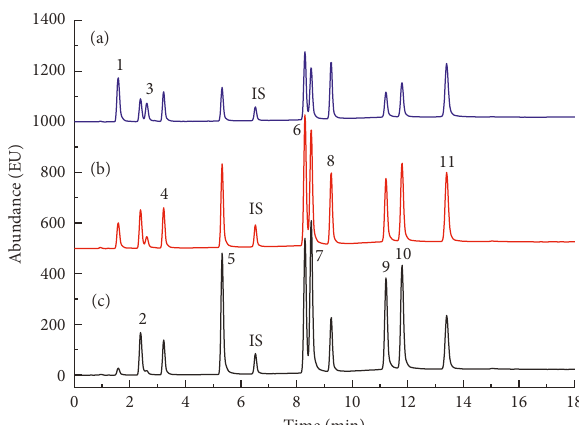
Figure 2: Chromatograms of the standard solution from ultrahigh- performance liquid chromatography with fluorescence detection. The numbers of compounds are the same as in Table 1. (a) Chromatogram detected at 325 nm; (b) chromatogram detected at 310nm; and (c) chromatogram detected at